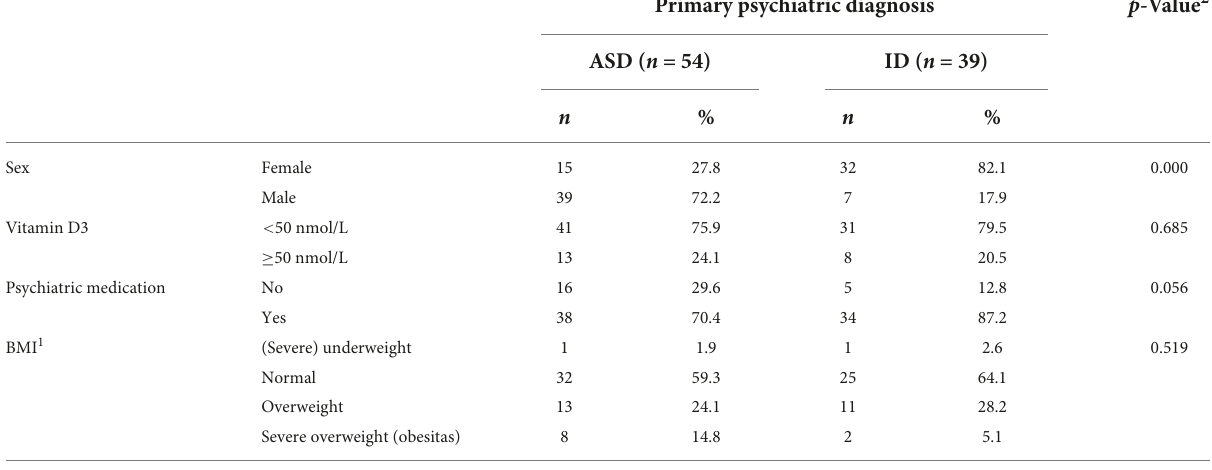
TABLE 2 Body mass index outcome, Vitamin D3, sex and psychiatric medication for children with ASD and children with internalizing disorders.